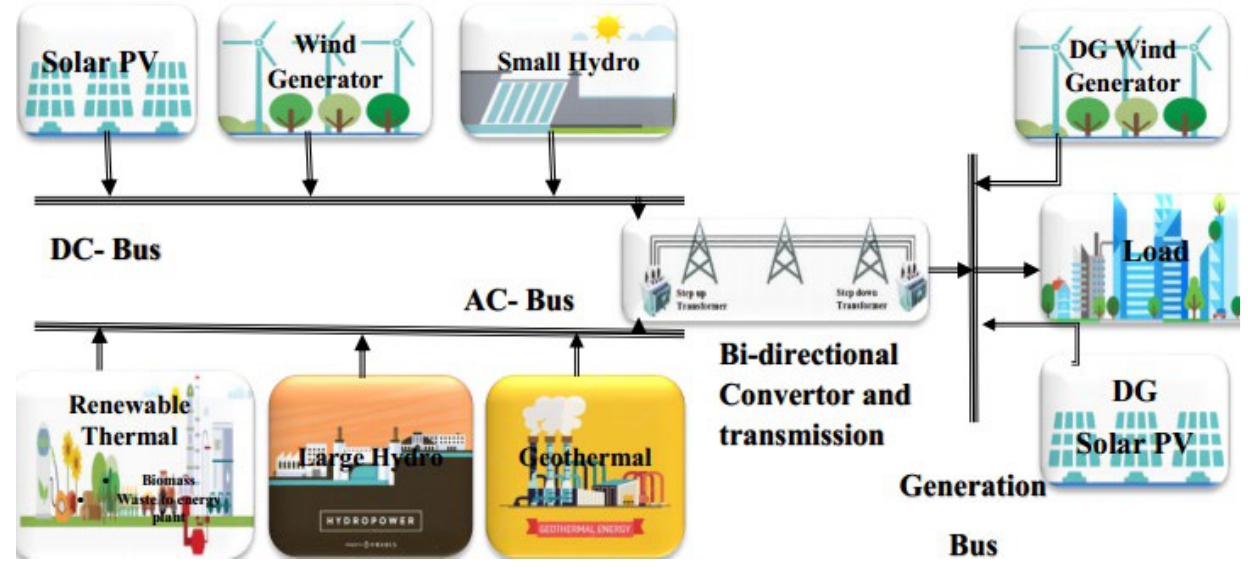
Figure 2. Schematic diagram of the proposed power